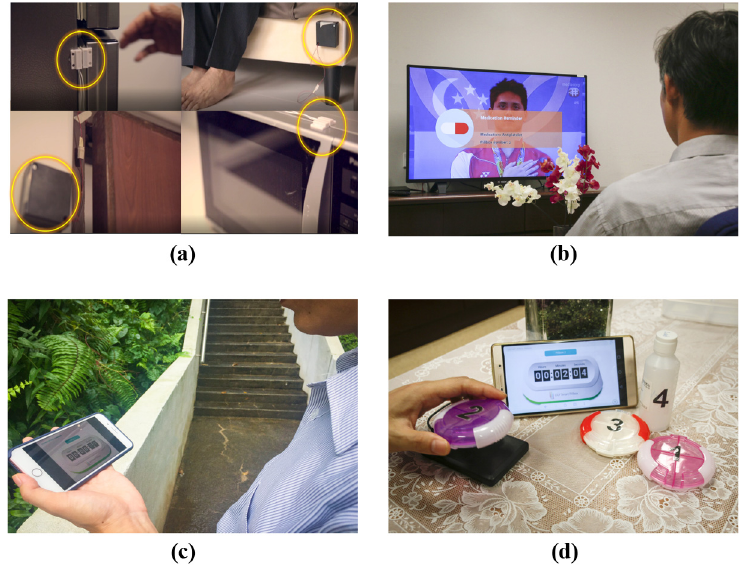
Figure 2. Implementation of